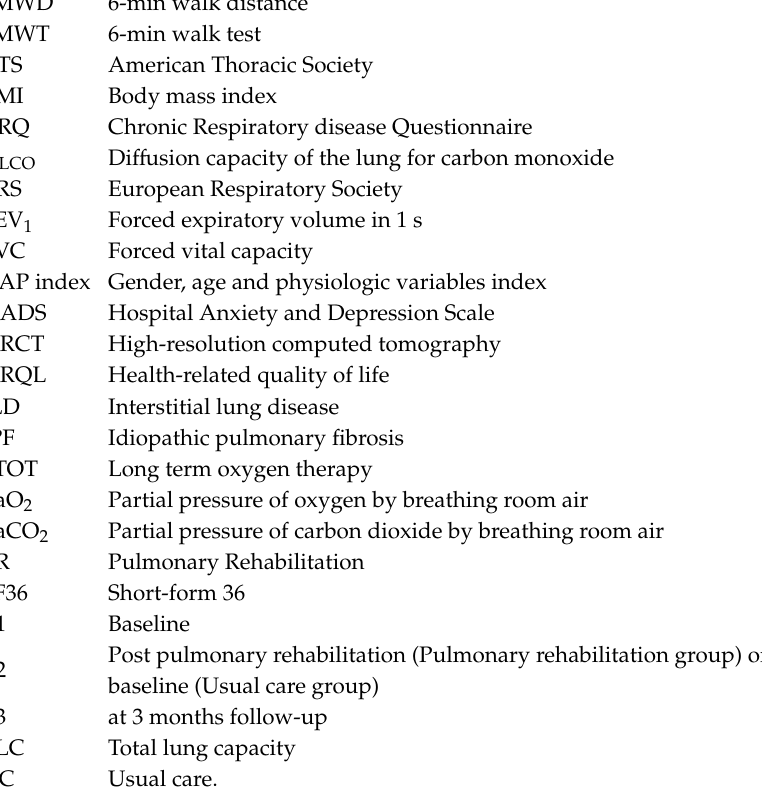
Figure S1: E ff ects of pulmonary rehabilitation (PR) in PR responder (circles) vs. PR non-responder (squares) on steps walked per day directly post intervention and at